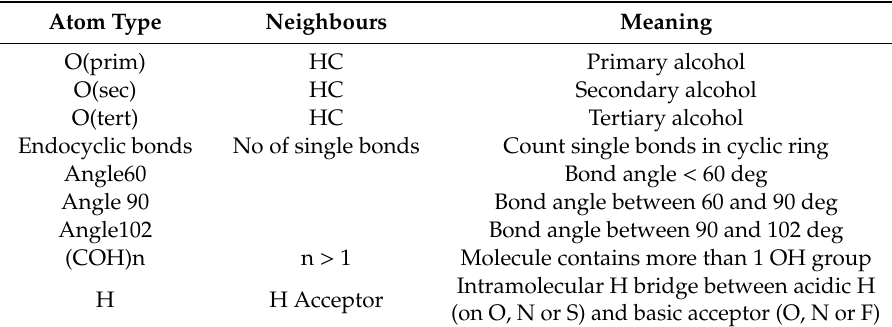
Table 2. Refined atom and special groups and their